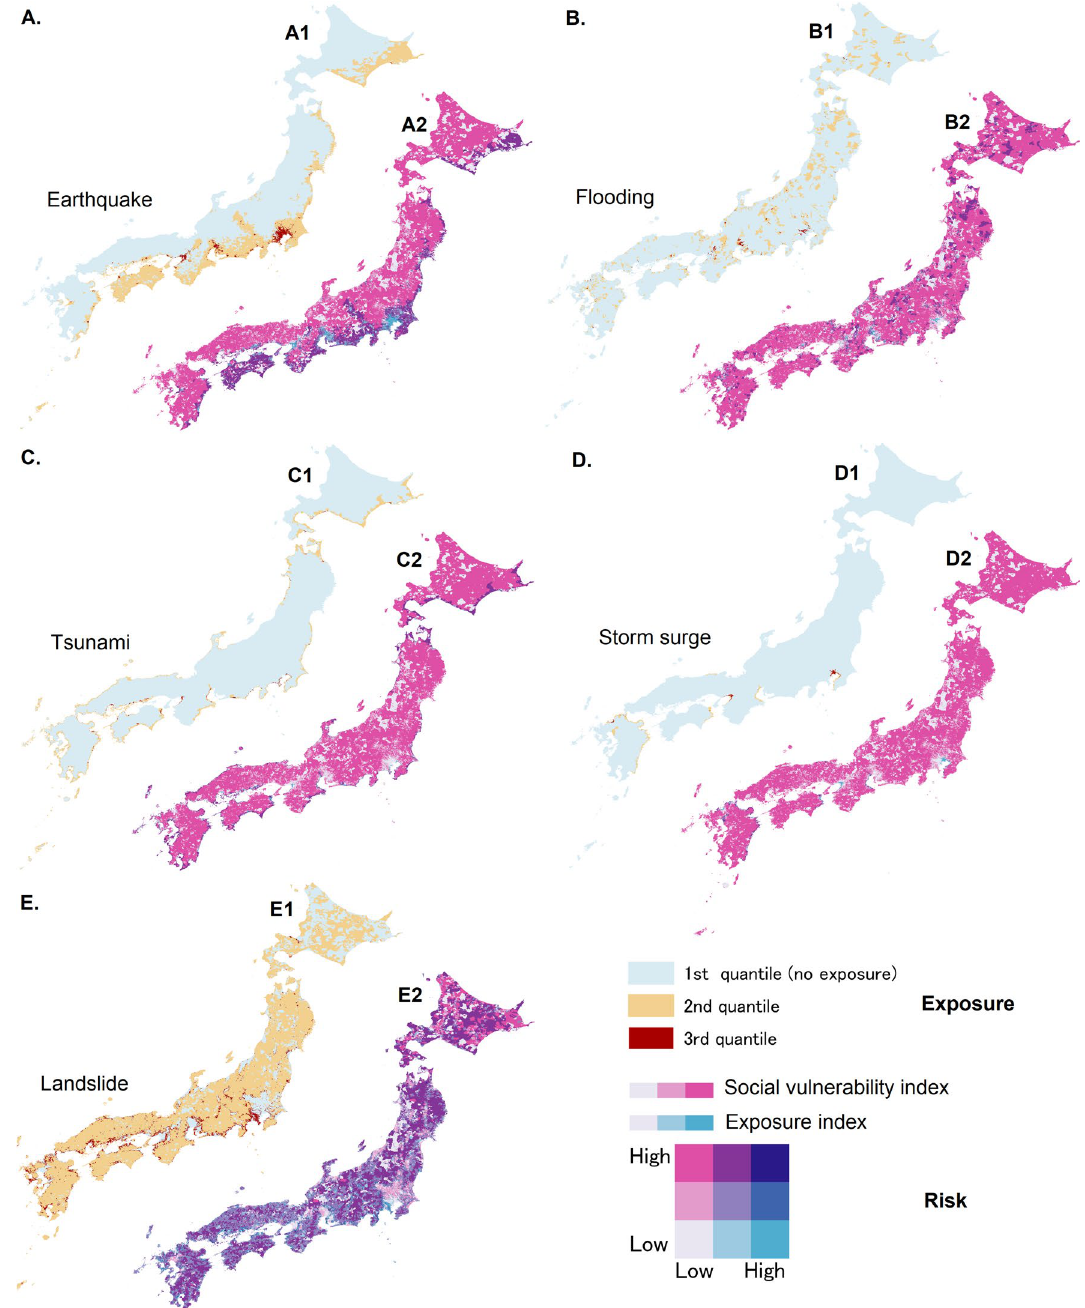
Figure 2. Measure of exposure (3 quantiles division) and visualisation of risk in a two-dimensional legend representation of social vulnerability and population exposure to 5 natural hazards in Japan. The left colour ramp (white/pink) represents 3 levels of social vulnerability while the right color ramp (white/light blue) represents 3 levels of exposure to earthquake disaster. Map generated using ArcGIS Pro